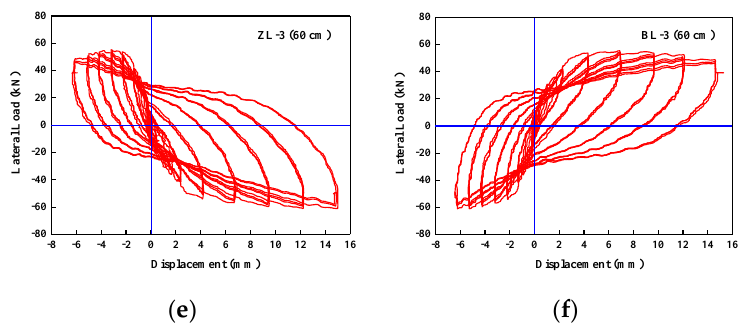
Figure 8. Variations between the lateral loading versus vertical displacement of PPECC-1. ( a ) ZL-1 (15 cm); ( b ) ZL-2 (30 cm); ( c ) ZL-3 (60 cm); ( d ) BL-1 (15 cm); ( e ) BL-2 (30 cm); ( f ) BL-3 (60 cm).